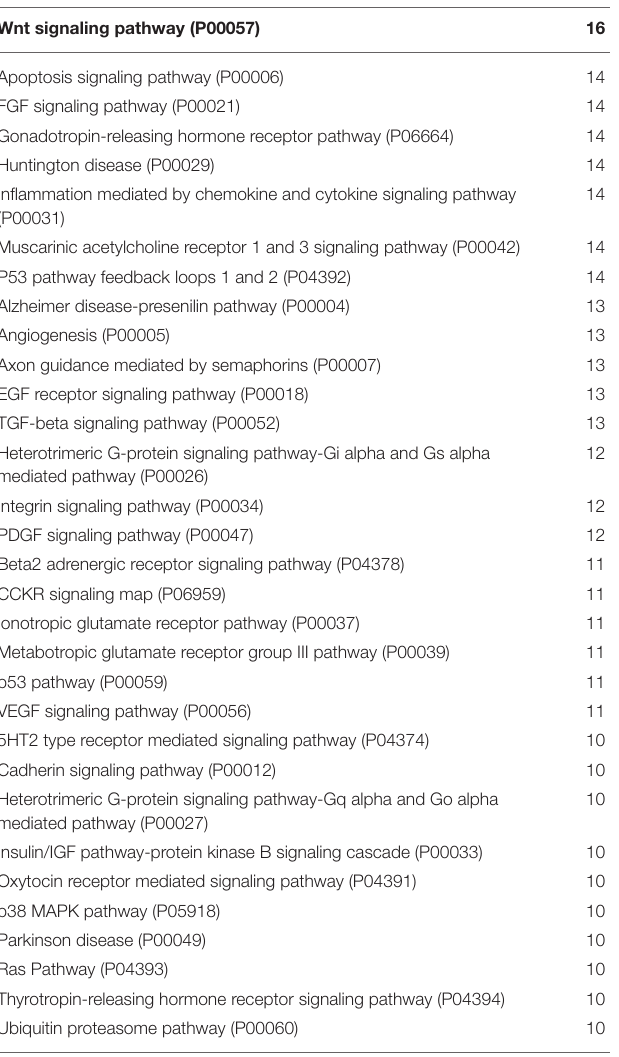
TABLE 1 | miRNA-targeted gene pathway analysis using Panther with a minimum of 10 hits.